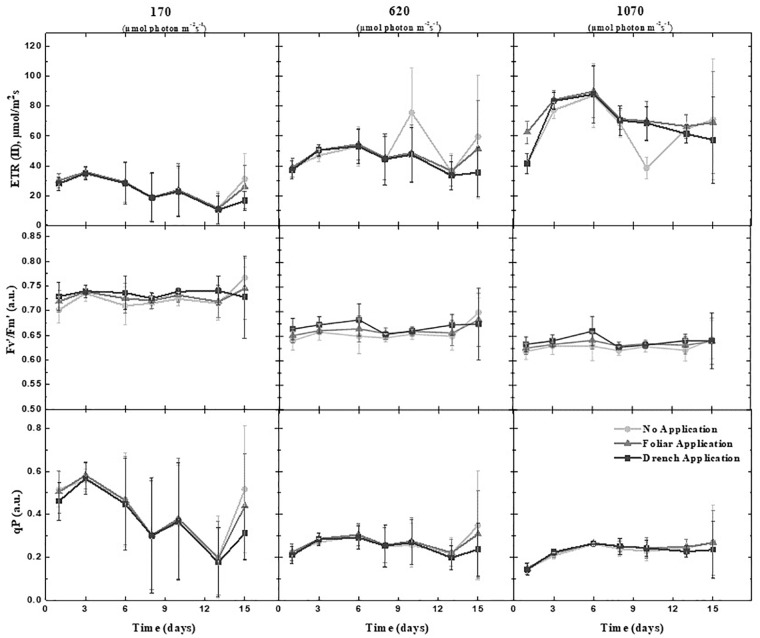
Photosynthetic performance of the tomato plants treated or untreated with protein hydrolysate. Range of photosynthetic parameters were deduced from kinetic chlorophyll fluorescence imaging prior to and following the PH treatments. The photochemical quenching coefficient that estimates the fraction of open PSII reaction centers (qP), maximum quantum yield of PSII photochemistry for the dark-adapted state (FV′/FM′), and electron transport rate (ETR) were measured using the light curve protocol. Data are mean of six independent plants per treatment. Measurements at three actinic photon irradiance intensities were acquired. Measurements were taken at 170, 620, and 1,070 μmol photons m−2 s−1, respectively.